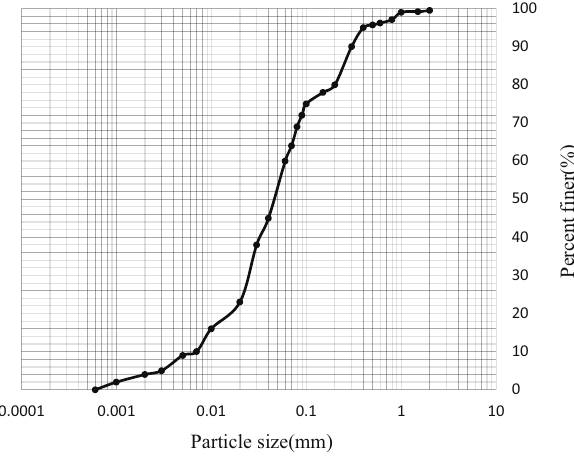
Figure 1: Particle size distribution curve of Shanghai